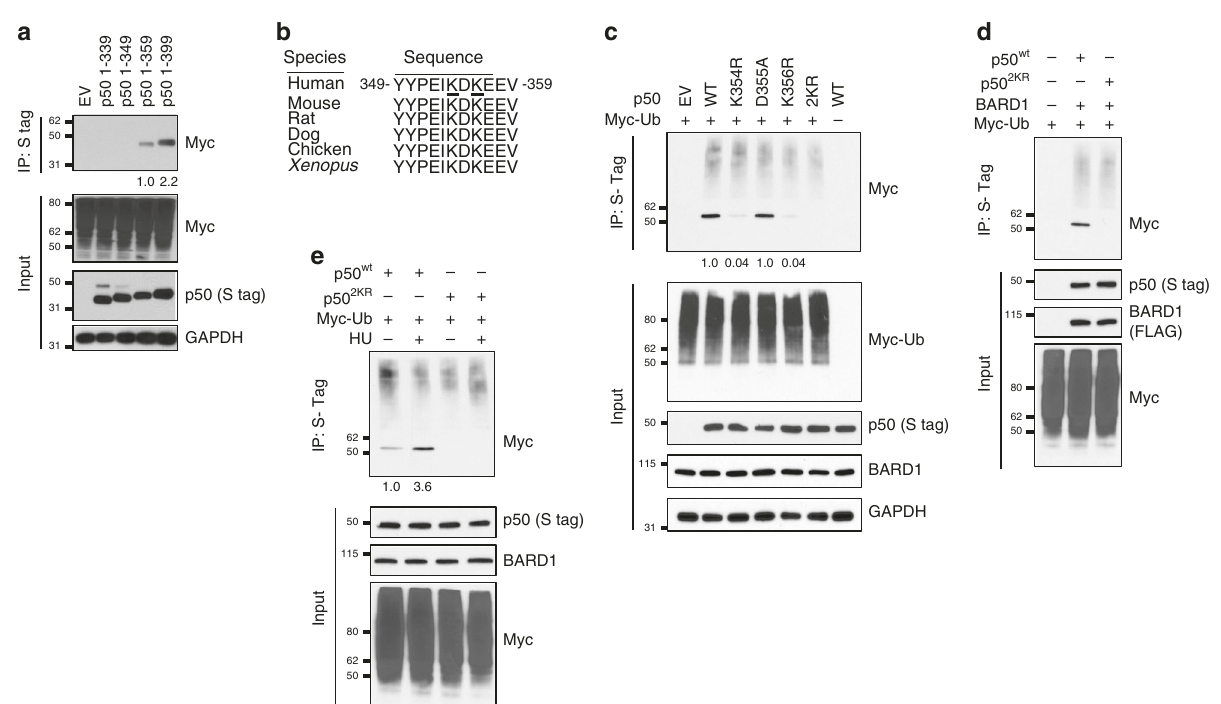
Fig. 4 p50 is mono-ubiquitinated at K354 and/or K356. a Co-IP in 293T cells transfected with Myc-Ub and the indicated S-tag p50 deletion construct. IP with S-agarose and IB with anti-Myc antibody. b Alignment of p50 sequences. Potential human mono-Ub sites underlined. c 293T cells transfected with Myc-Ub, S-tag p50 wt , or the indicated p50 mutant. 2KR, K354R/K356R. IP with S-agarose and IB with anti-Myc antibody. d Bard1 -null cells transfected with FLAG-BARD1, Myc-Ub, S-tag p50 wt , or p50 2KR . IP with S-agarose and IB with anti-Myc antibody. e 293T cells transfected with Myc-Ub, S-tag p50 wt or p50 2KR , and treated with HU (2 mM, 4 h). IP with S-agarose and IB with anti-Myc antibody. All blots are representative of at least two biologically independent experiments. Analysis of fold-change normalized to control lane shown below IB where